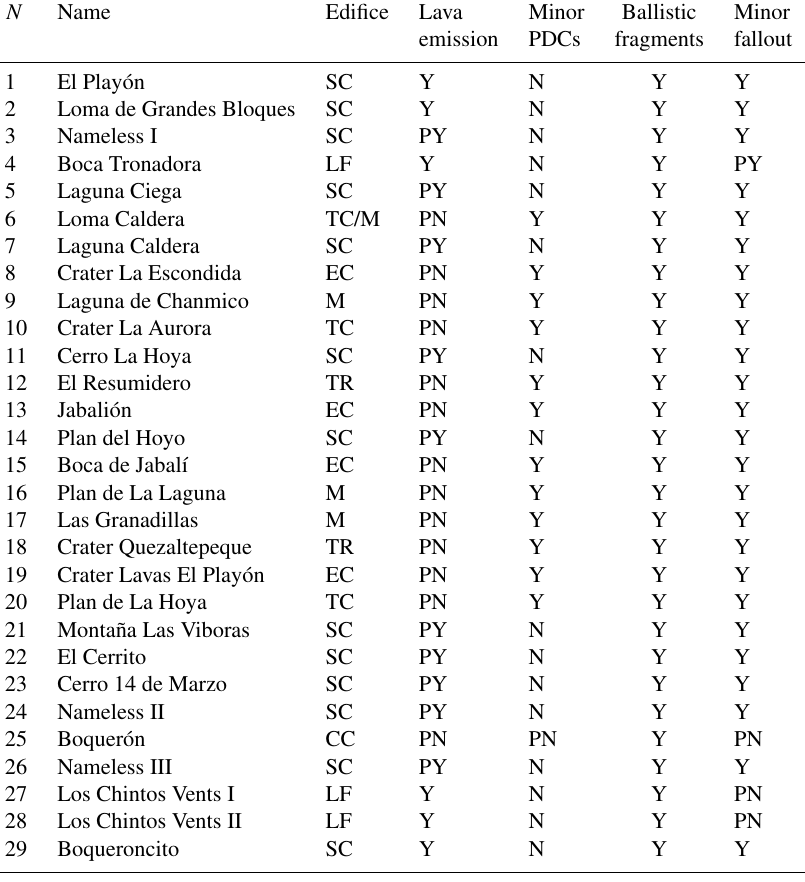
Table 1. Vents considered in the SSVC (Sofield, 1998; Ferrés et al., 2011, 2013; Ferrés, 2014). N